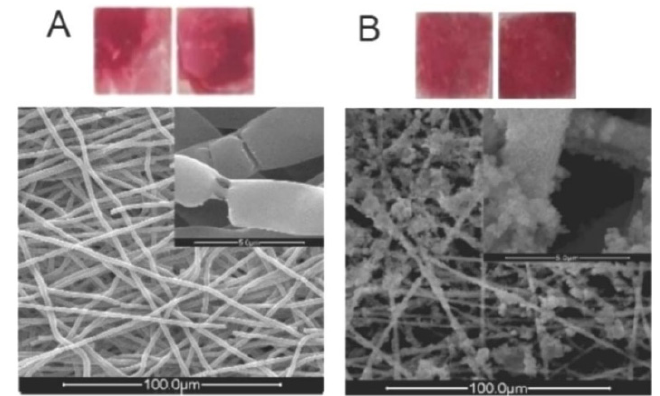
Figure 5. ( A ): Digital image of an ARS-stained sample that has been treated with the standard nucleation procedure (SNP) after being dipped in EtOH; bottom: SEM image of the same sample. ( B ): Digital image of an ARS-stained sample that has been treated with the SNP after being activated by ultrasonic waves; top: SEM image of the same sample. Reproduced with permission from Ref. [98]. Then, the activated nanofibers were alternately immersed in the mineralization solu- tions (20 mL/cm 2 1000 mM CaCl 2 .2H 2 O and 20 mL/cm 2 600 mM Na 2 HPO 4 solutions) and